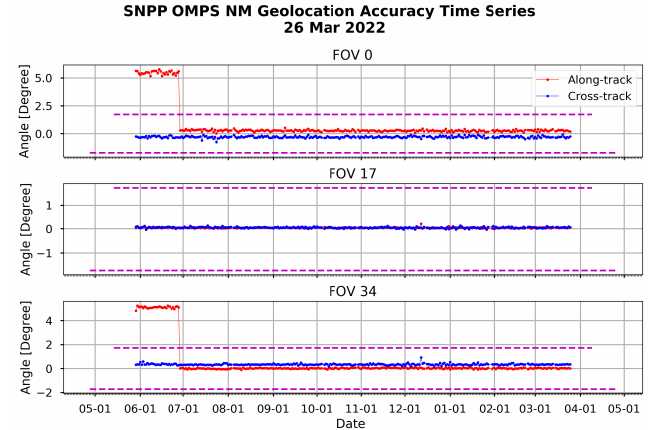
Figure 13. Time series of the assessment results for NOAA-20 OMPS-NM at macropixel FOV 0, 17 and 25, where different y -axis scales are used for three plots. The dashed lines indicate the ±1/2 FOV size in terms of degree. The time series extended from 27 May 2021 to 26 March 2022 (309 days) and the data in each day contains 150–200 OMPS-NM lines with randomly selected non-uniform scenes.